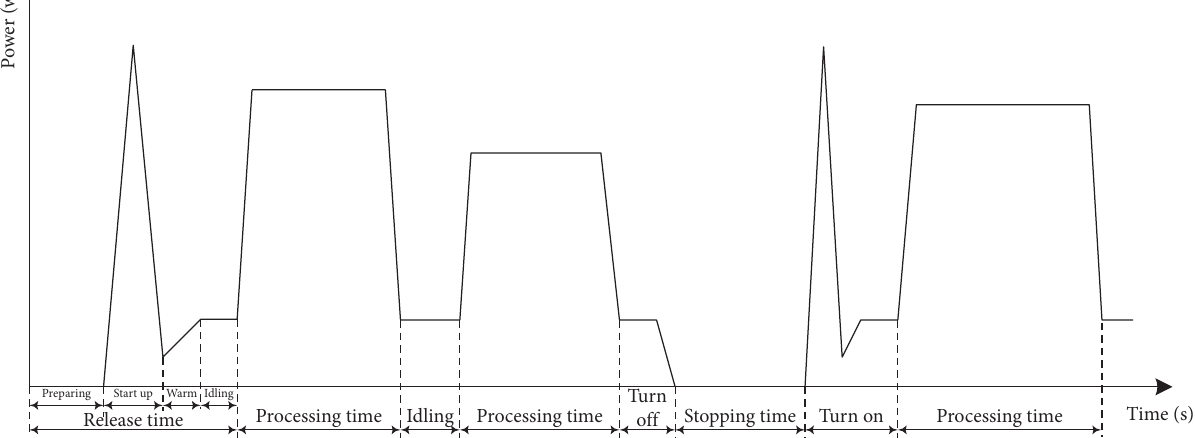
Figure 2: Example of energy consumption of a processing